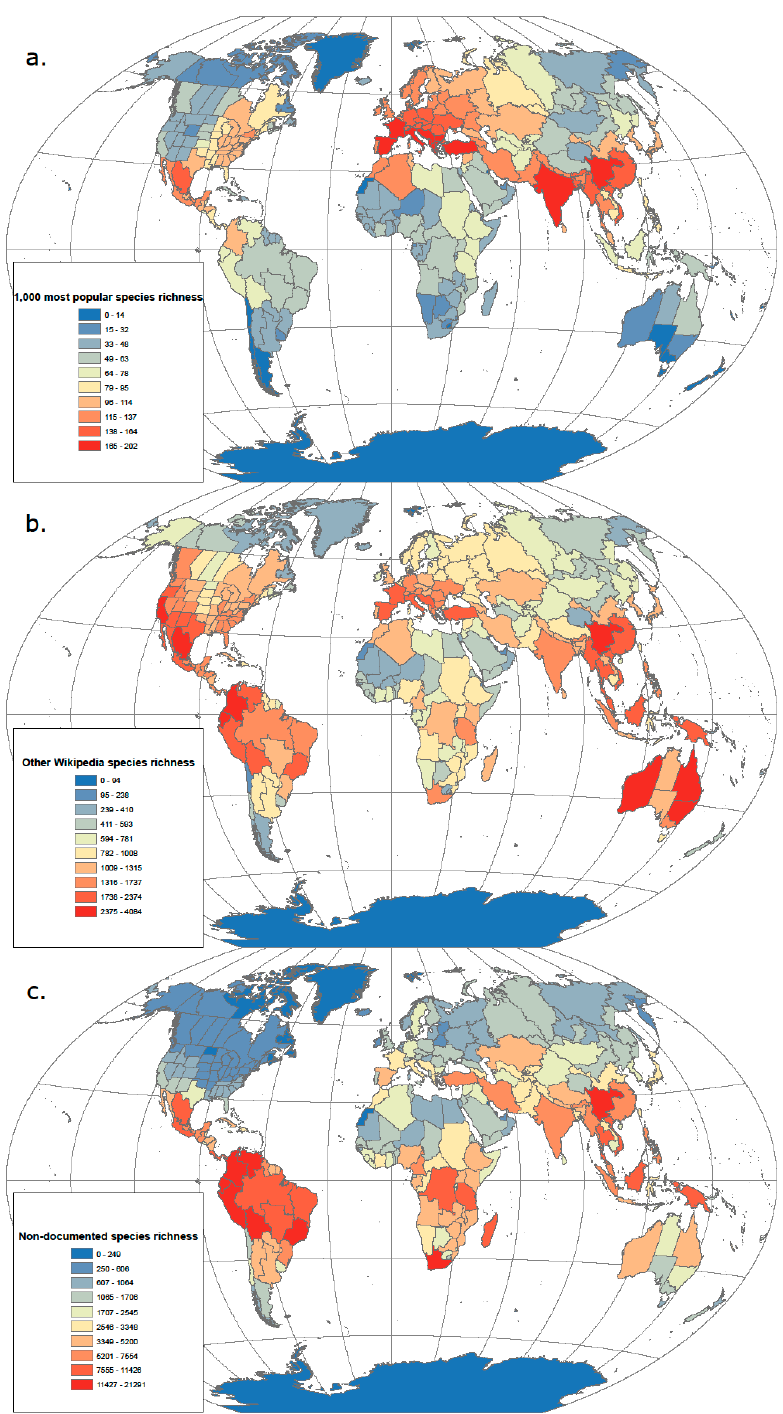
Figure 2. Global distribution of the species richness of plants ranging from popular to anonymous based on English Wikipedia page views. Global distribution of ( a ) the 1000 most popular plant species on Wikipedia; ( b ) 49,019 species documented in Wikipedia, excluding the 1000 most popular ones; ( c ) 280,905 species not documented in Wikipedia. Popularity was measured as the number of views of the Wikipedia webpage of each species. Native distribution data was retrieved from the World Checklist of Vascular Plants at the national or sub-national level of the World Geographical Scheme for Recording Plant Distribution (WGSRPD) [51].